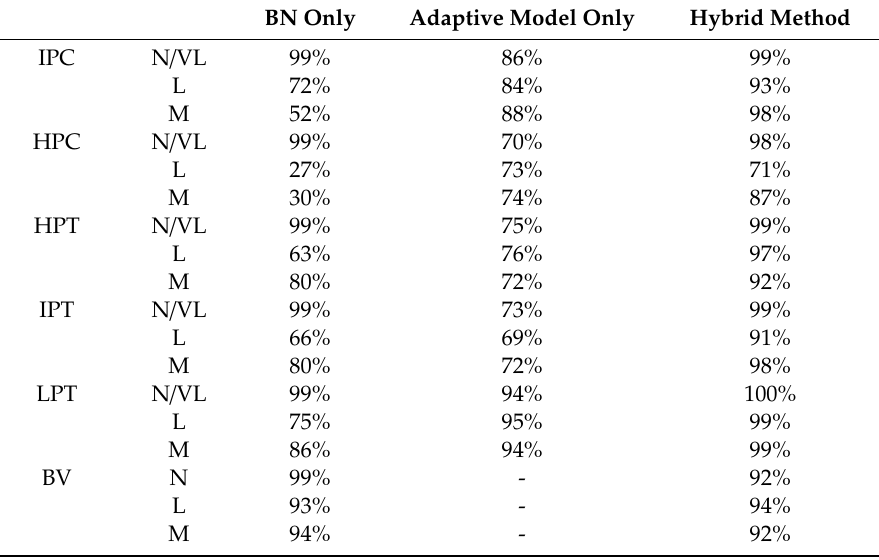
Table 6. Correctly identified faults with production